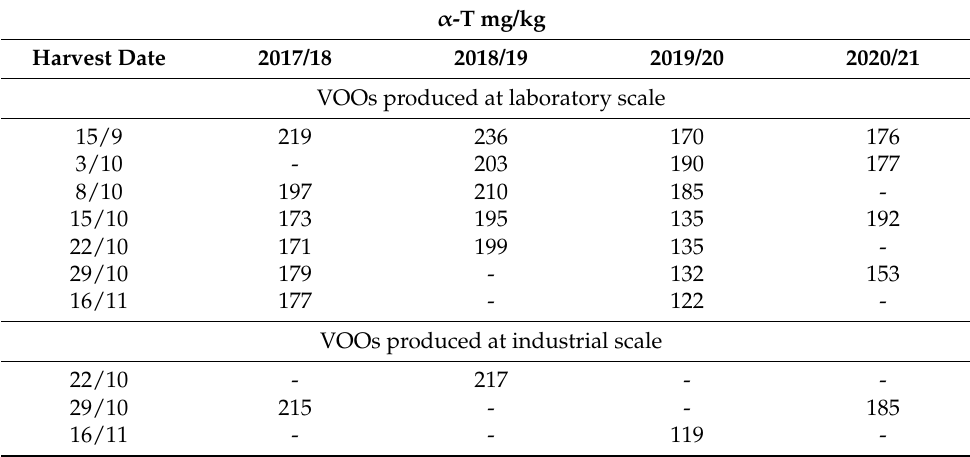
Table 6. Variability in the α -Tocopherol ( α -T) content of VOOs extracted from olives cv. Chondrolia Chalkidikis and Chalkidiki at different stages of maturity for four consecutive harvest